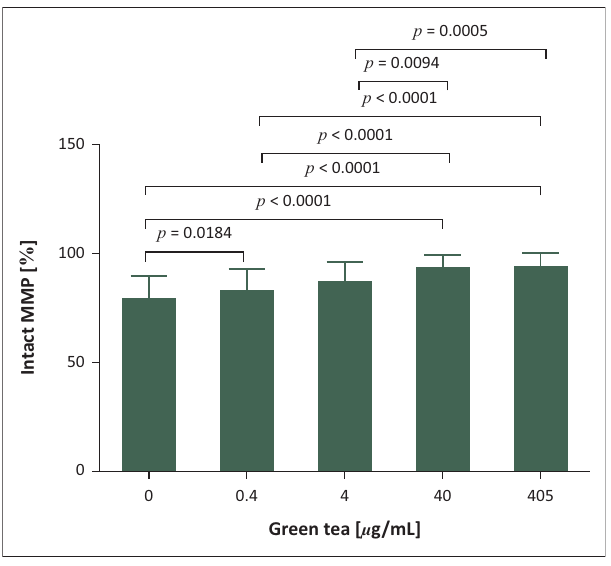
FIGURE 3: Effect of green tea aqueous extract on intracellular reactive oxygen species. Data are represented as mean ± standard deviation from normozoospermic semen samples ( n = 40).